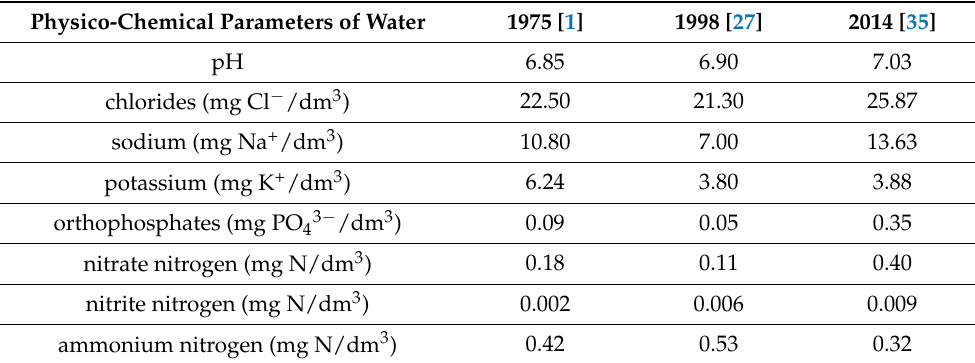
Table 4. Variability of physico-chemical parameters of the water of the Nowoku´znicki pond in the period 1975–2014 (mean